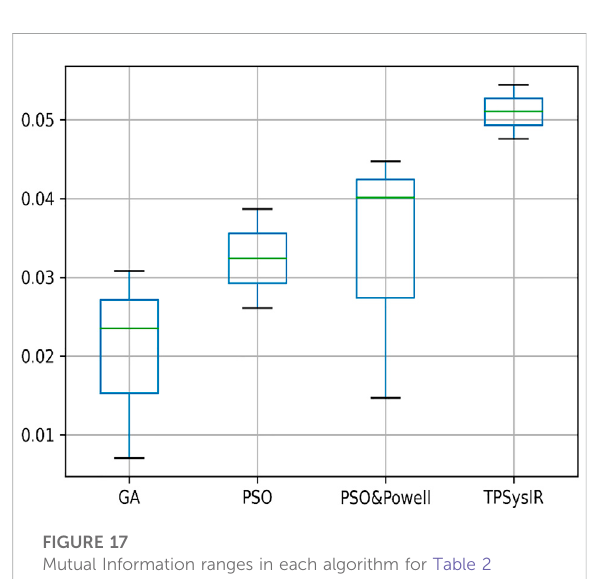
FIGURE 15 Mutual Information ranges in each algorithm for Table 2 Multimodal Experiment 1.